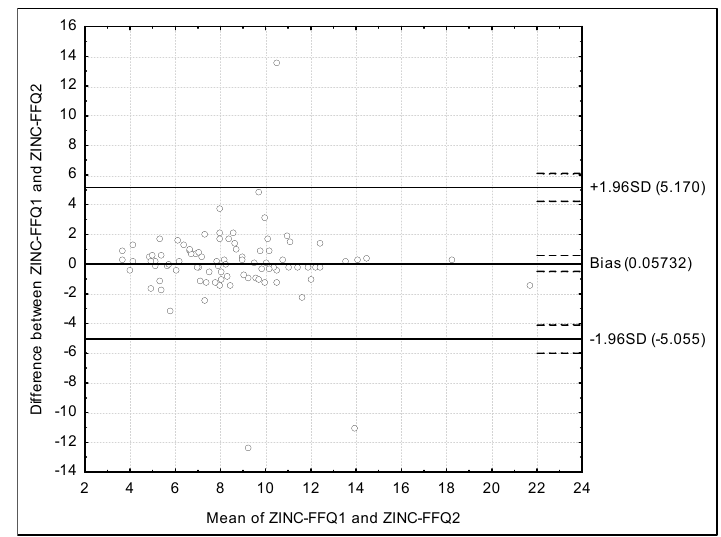
Figure 4. The assessment of the reproducibility of the ZINC-FFQ conducted using the Bland–Altman plot (Bland–Altman index of 3.3%). ZINC-FFQ1 = first food frequency questionnaire. ZINC-FFQ2 = second food frequency questionnaire.